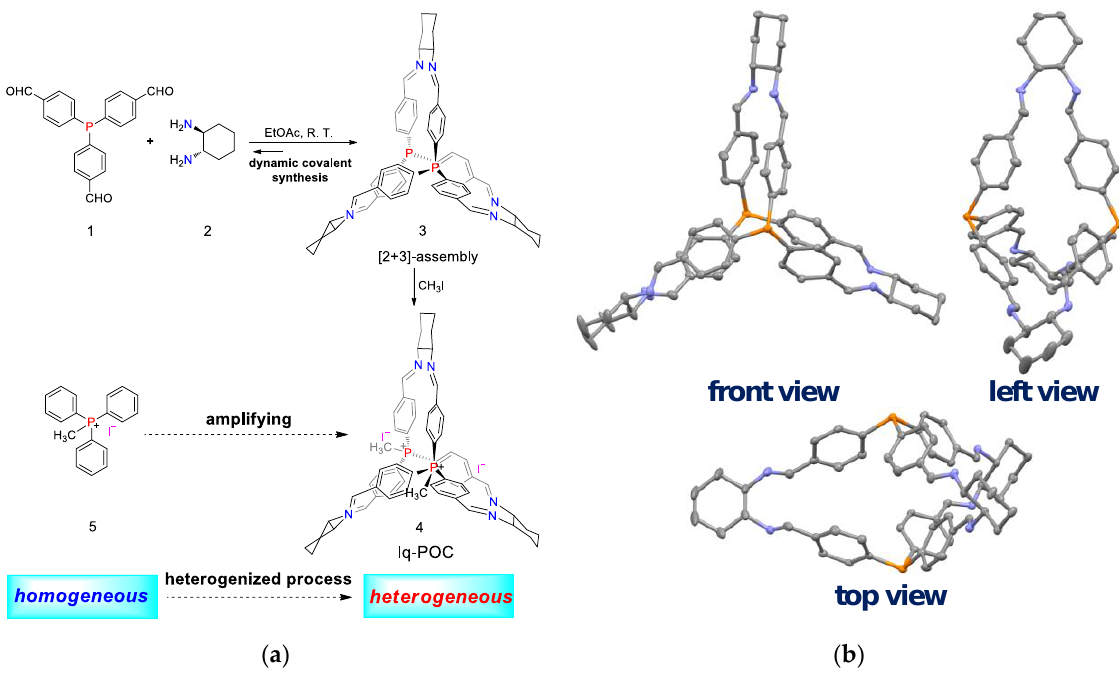
Figure 1. ( a ) Synthesis of the nucleophile catalyst ionic quasi-porous organic cage ( Iq-POC ), and ( b ) the crystal structure of cage 3 (H atoms are omitted for clarity; ellipsoids are drawn at 30% probability level). CCDC number: 1857683.